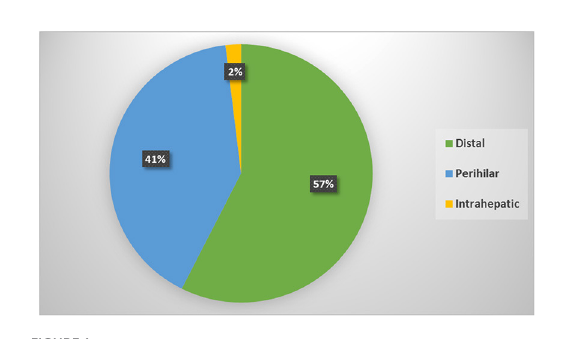
FIGURE1 Percent of different types of biliary strictures (BS) according to our